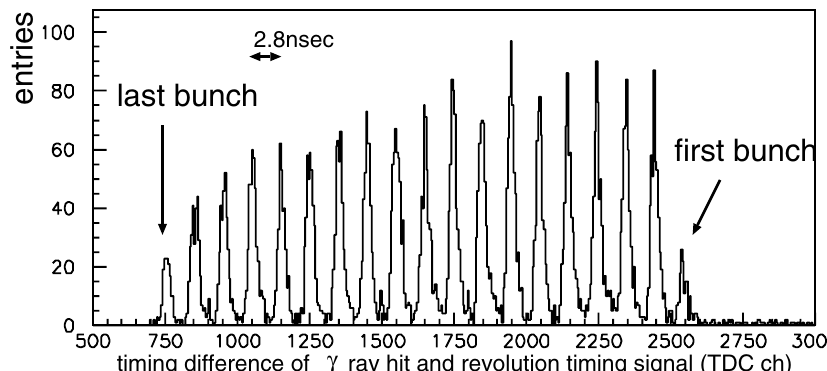
FIG. 1. Time spectrum of the gamma ray in a multibunch operation. The abscissa is the timing difference between gamma ray hits and the revolution timing